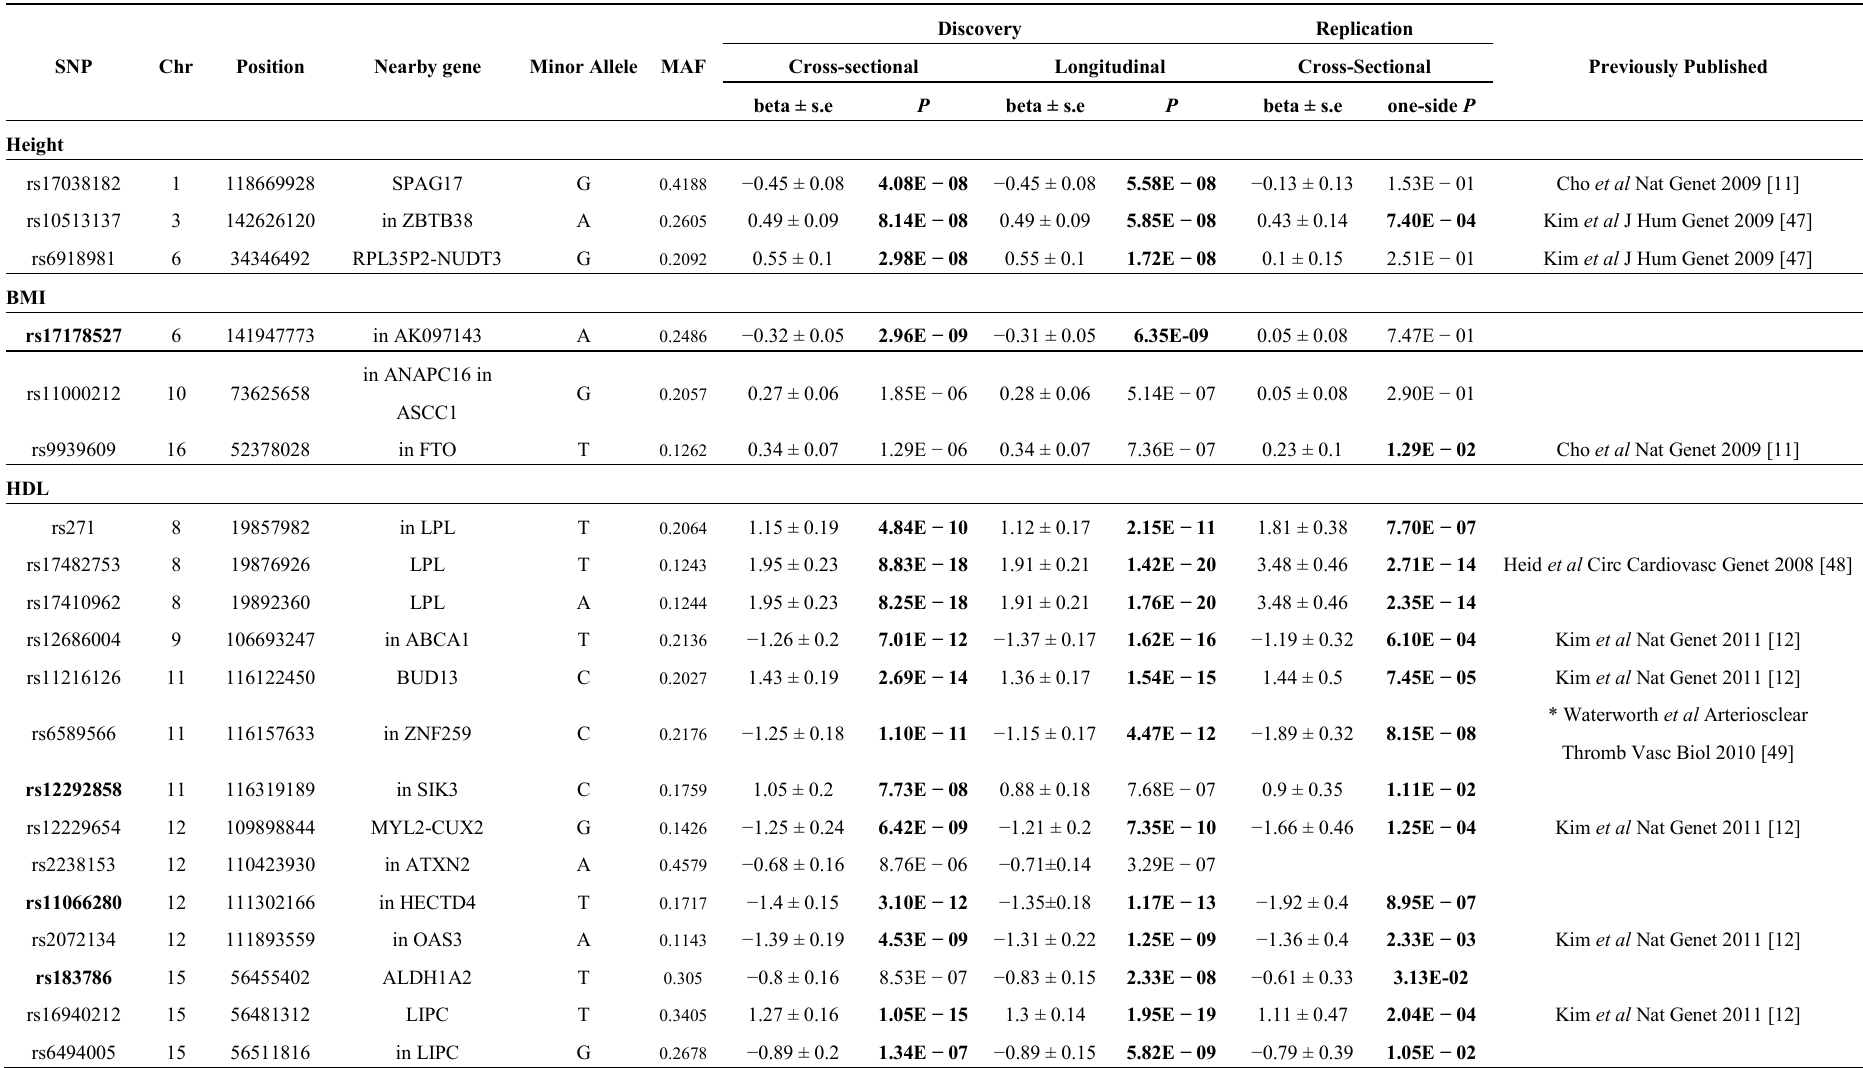
Table 6. Results for Height, BMI, HDL and log AST. SNPs with p -values less than 10 −6 from cross-sectional or longitudinal data are